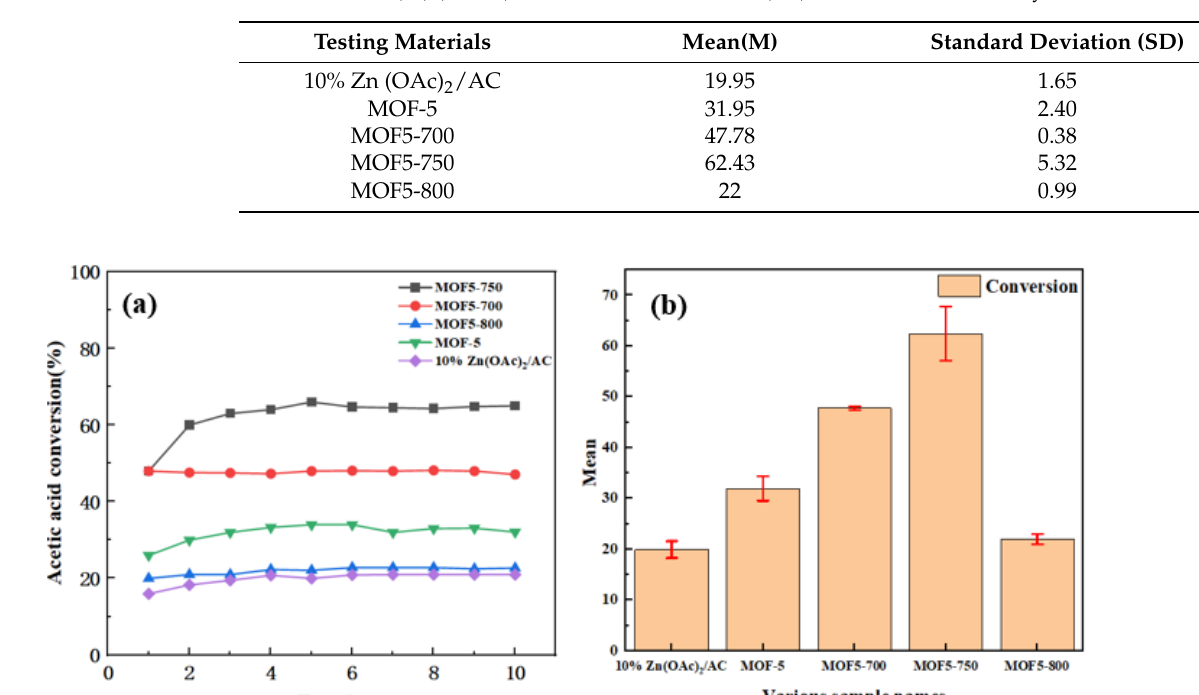
Figure 8. Conversion of acetic acid based on MOF-5, MOF5-700, MOF5-750, MOF5-800 and 10% Zn(OAc) 2 /AC ( a ) and means (M) and standard deviations (SD) of the five sets of catalyst variables ( b ).